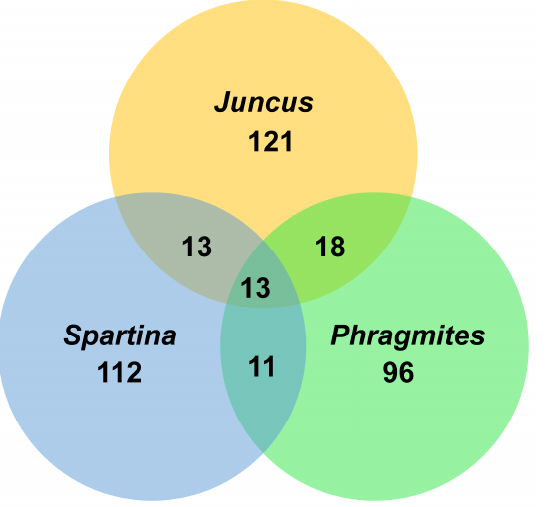
Figure 17. Venn diagram showing the association of salt marsh fungi from commonly studied halophytes.